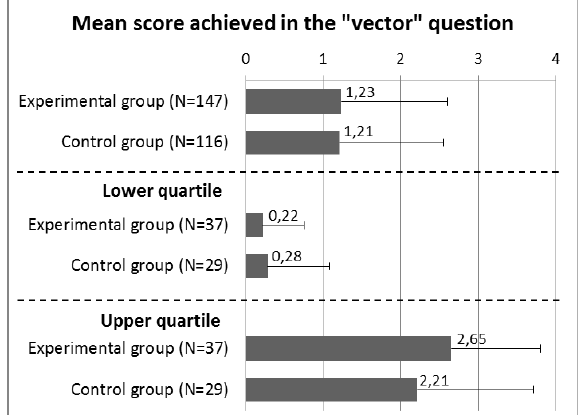
Figure 4. The mean score achieved in the “vector” question. Both the experimental group and control group include the exams from three different semesters. The lower quartile includes the students with lowest total score in the exam, the upper quartile the students with the highest total score (excluding the “vector”